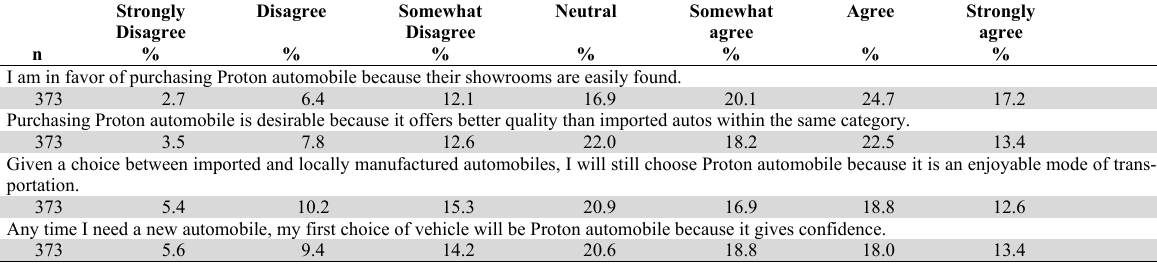
Tabulated attitudinal statements with response